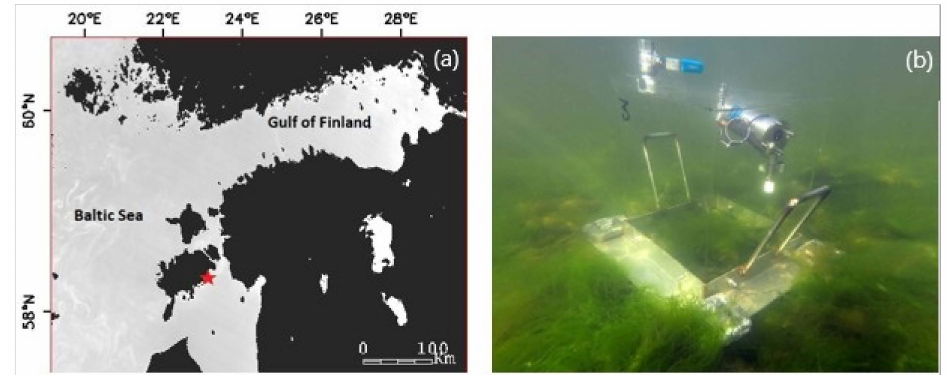
Figure 1. ( a ) Location of the experimental site in the Baltic Sea. ( b ) Underwater chamber to quantify the in situ photosynthetic production of plant